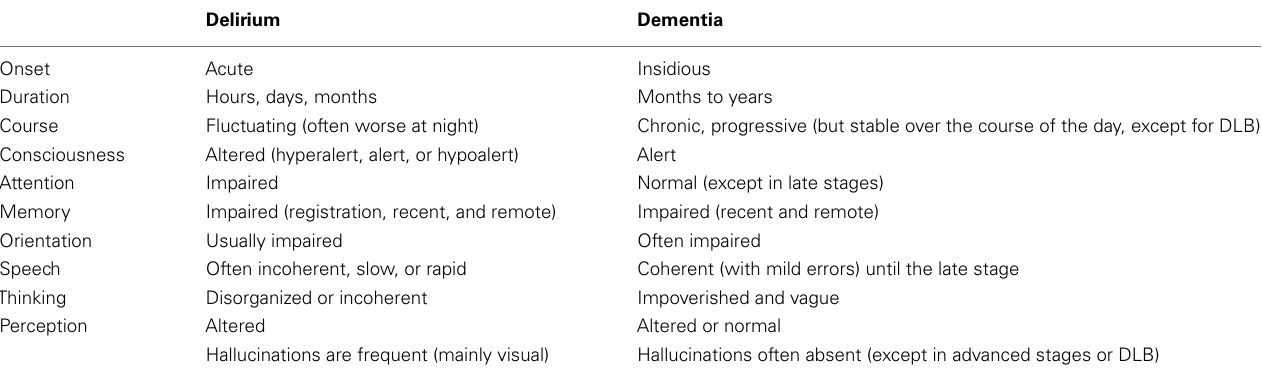
Table 1 | Differential diagnoses of delirium and